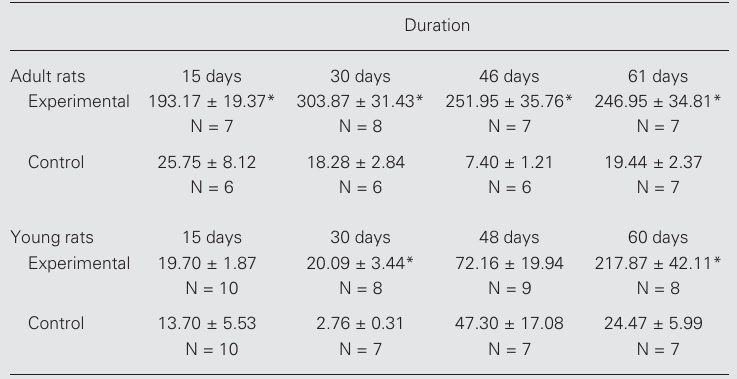
Table 4. Serum prolactin levels of adult and young animals treated with domperidone.